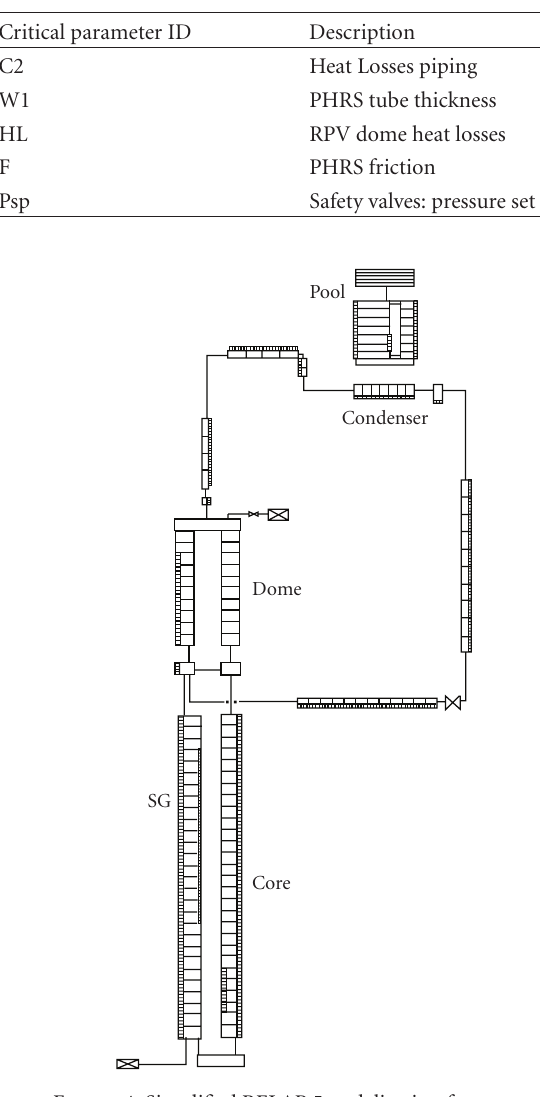
Figure 3: Sketch of TTL-1 loop.